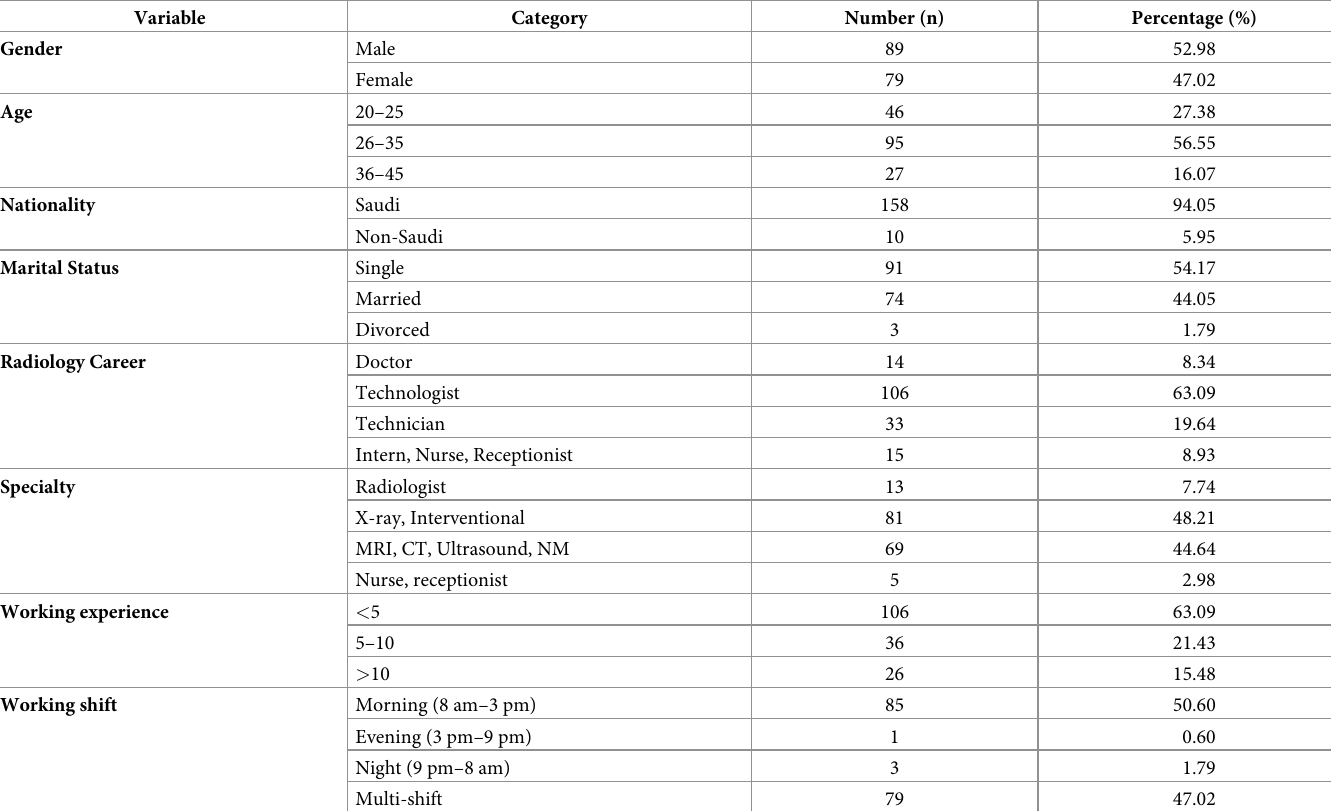
Table 1. Demographic characteristics of